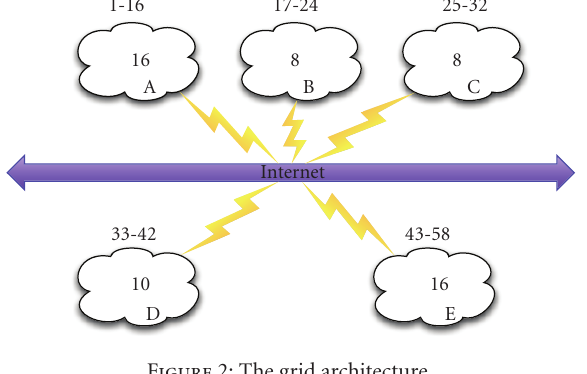
Figure 2: The grid architecture.